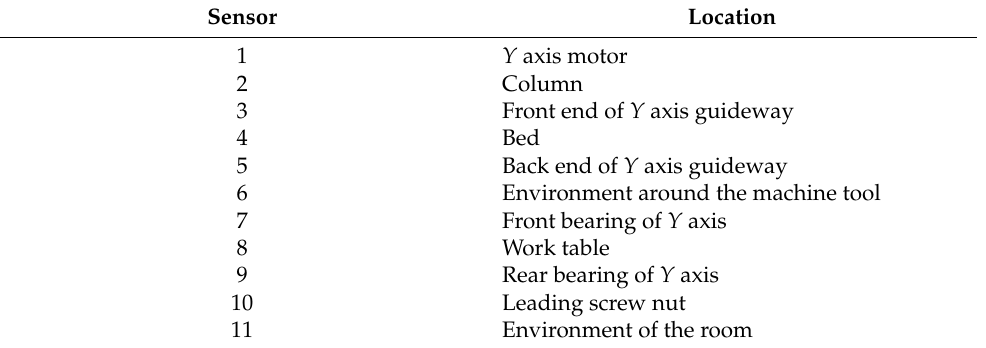
Figure 6. The arrangement of temperature sensors. Table 1. The installation locations of temperature sensors.